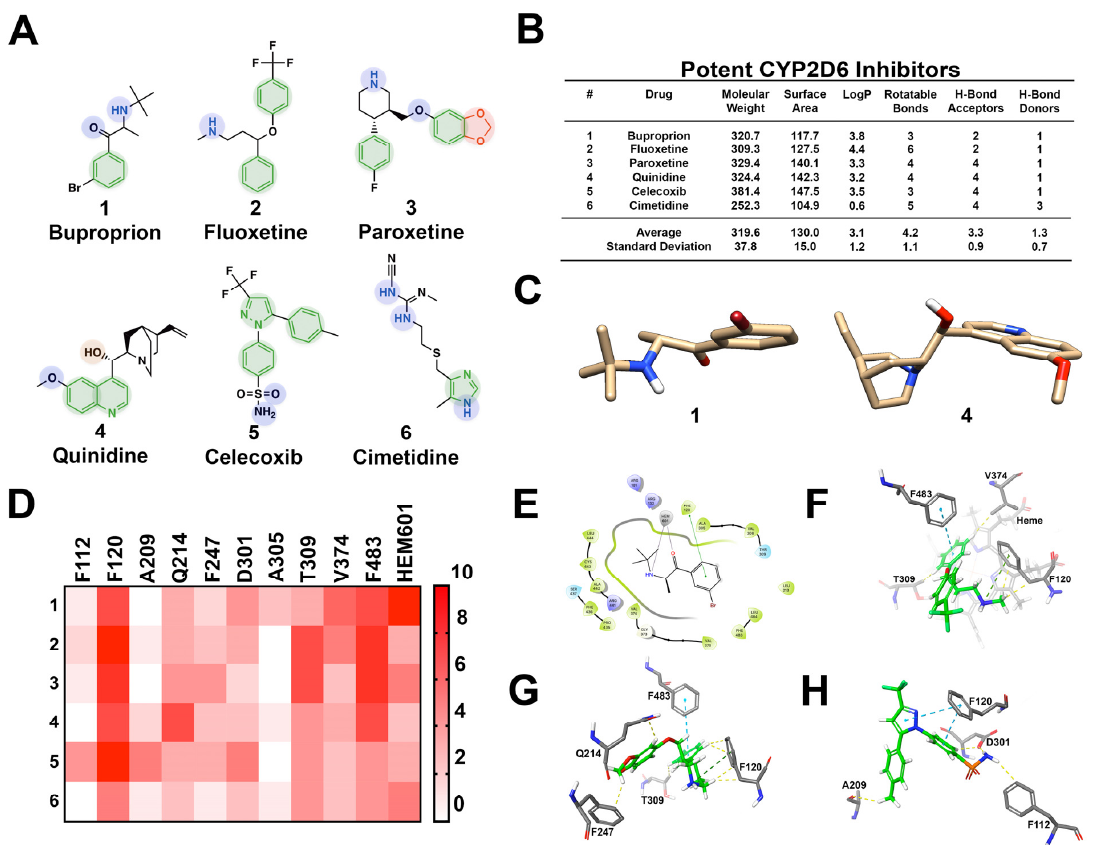
Figure 5. Structural investigation of 6 well-known high-affinity CYP2D6 inhibitors. ( A ) CYP2D6 inhibitors commonly have one or multiple aromatic moieties, heterocycles, and primary or secondary amines. Red and green moieties interact with F112, F120, F247, F483, and/or heme-601; blue moieties interact with DD301 and/or heme-601, and orange interact with D301. ( B ) CYP2D6 inhibitors are rigid, moderately sized structures with varying physiochemical properties. ( C ) CYP2D6 inhibitors are flat, planar structures capable of becoming positively charged. ( D ) Heat map representing the frequency of ligand-to-amino acid binding interactions in the top ten most energetically favorable binding poses in docking against CYP2D6 (PDB ID: 3QM4). Key amino acids include F120, Q214, D301, T309, V374, and F483. Frequent interactions are observed with heme as well. ( E ) Two-dimensional ligand interaction map showing the secondary amine and carbonyl group of buproprion coordinating with Heme-601. ( F ) Three-dimensional docking image depicting fluoxetine interaction with F120, T309, V374, and F483. ( G ) Three-dimensional docking image showing paroxetine forming pi–pi stacking interactions with F120, F247, and F83, as well as energetically favorable contacts with Q214 and T309. ( H ) Three-dimensional docking image showing celecoxib interacting with F120, F112, A209, and